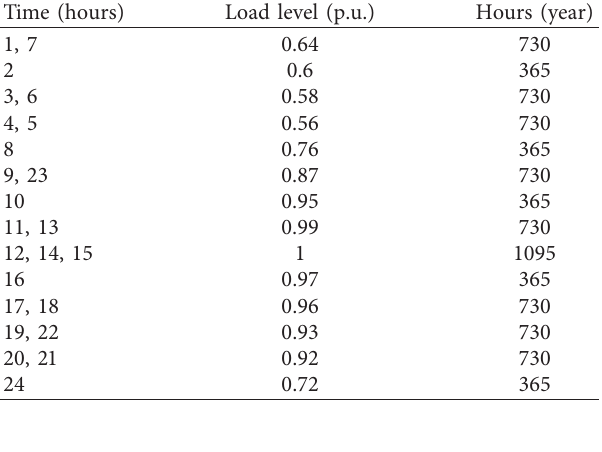
Table 1: Average hourly daily load demand [51]. Time (hours) Load level